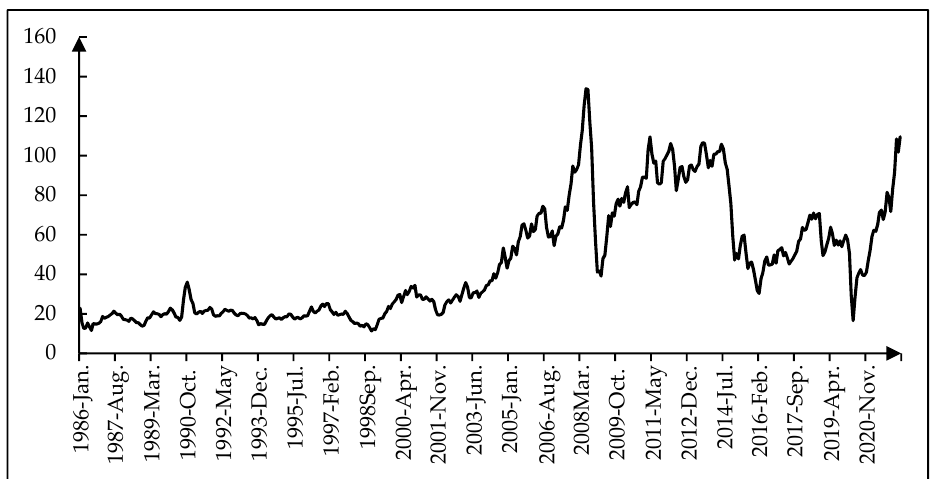
Figure 1. The WTI spot price (source: https://www.eia.gov/dnav/pet/pet_pri_spt_s1_d.htm (accessed on 23 June 2022)).